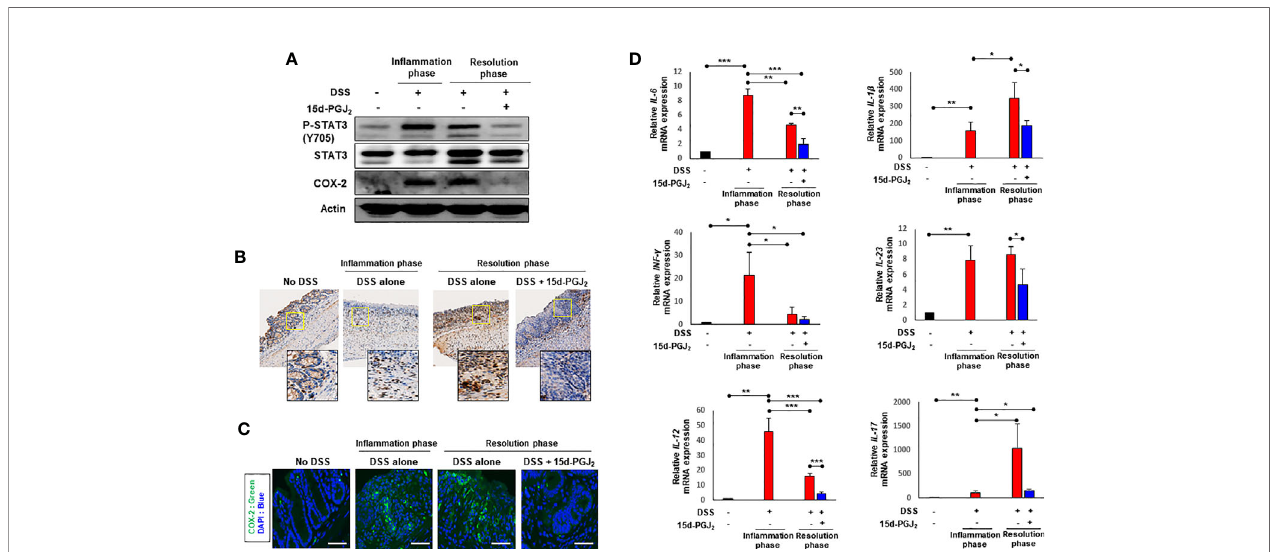
FIGURE 6 | 15d-PGJ 2 inhibited DSS-induced STAT3 phosphorylation and expression of COX-2 and pro-in fl ammatory cytokines in mouse colon. Colon tissue were collected on day 7 (in fl ammation phase) and day 13 (resolution phase). (A) The levels of P-STAT3 (Y705) and COX-2 were determined by immunoblot analysis. Actin was used as an equal loading control for normalization. (B) Immunohistochemical detection of P-STAT3 (brown spots) in colon tissue were determined. To verify the expression of COX-2 in colon tissue, (C) immuno fl uorescence analysis was conducted using anti-COX-2 antibody. Scale bar, 200 m m. (D) Pro-in fl ammatory cytokines including IL-6, IL-1 b , INF- g , IL-23, IL-12 , and IL-17 were determined in colon tissue by real-time PCR. *, **, *** Signi fi cantly different between the groups compared (* p < 0.05, ** p < 0.01, and *** p <